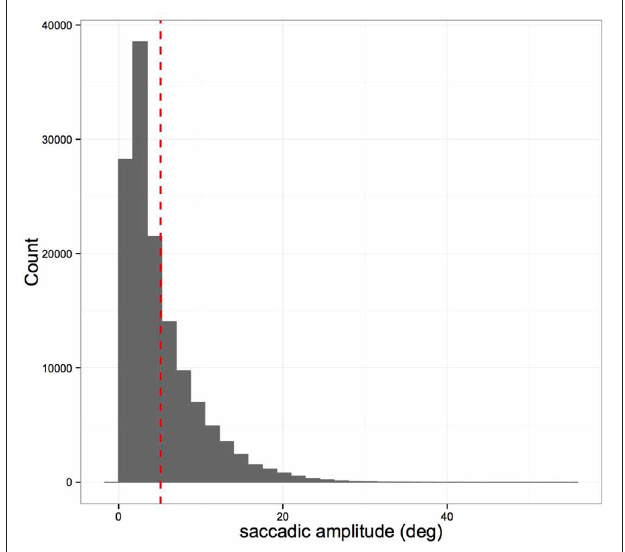
FIGURE 1 | Distribution of saccade amplitudes (in degree) of 73 subjects. The majority of saccade amplitudes ranged between 1 and 10 ◦ , and below 20 ◦